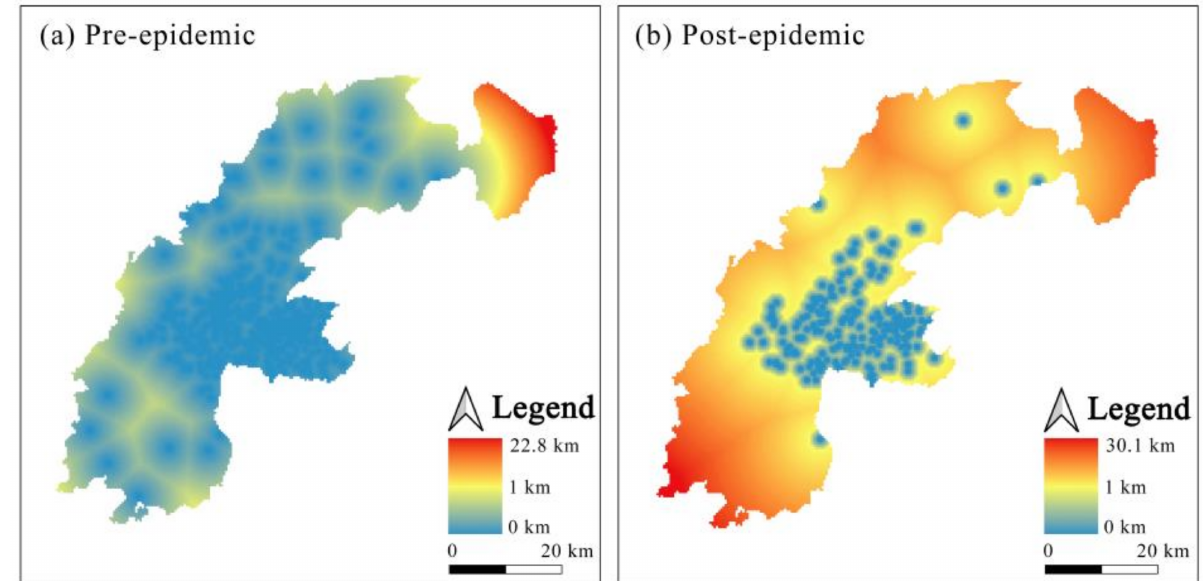
Figure 10. The buffer distance to outdoor sports venues: ( a ) pre-epidemic; ( b )